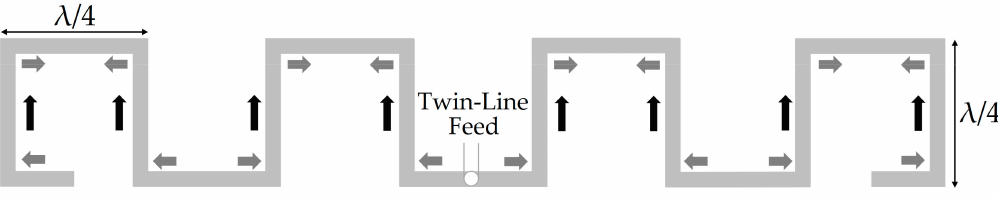
Figure 1. A typical twin-line fed 8-element wire Bruce array antenna